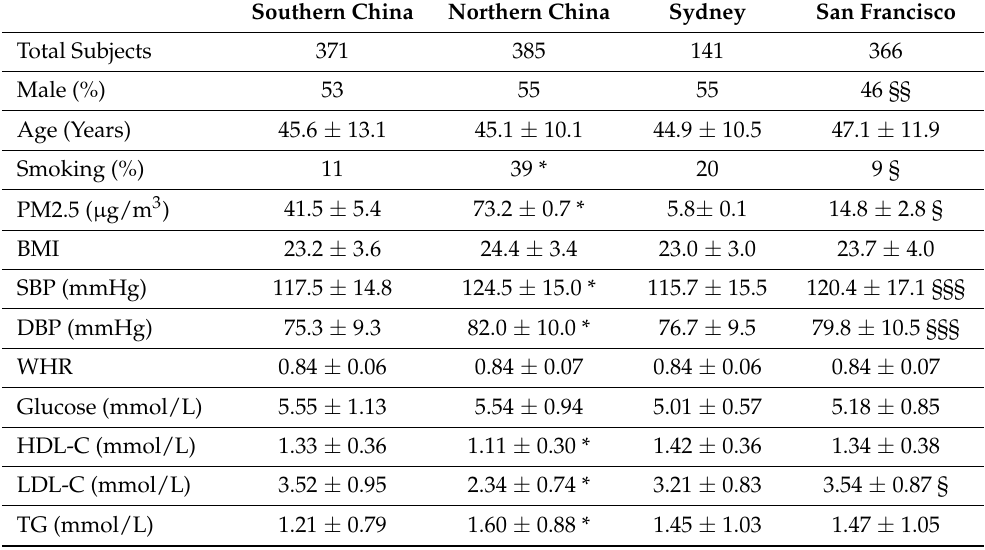
Table 2. Demographic and clinical characteristics of 1263